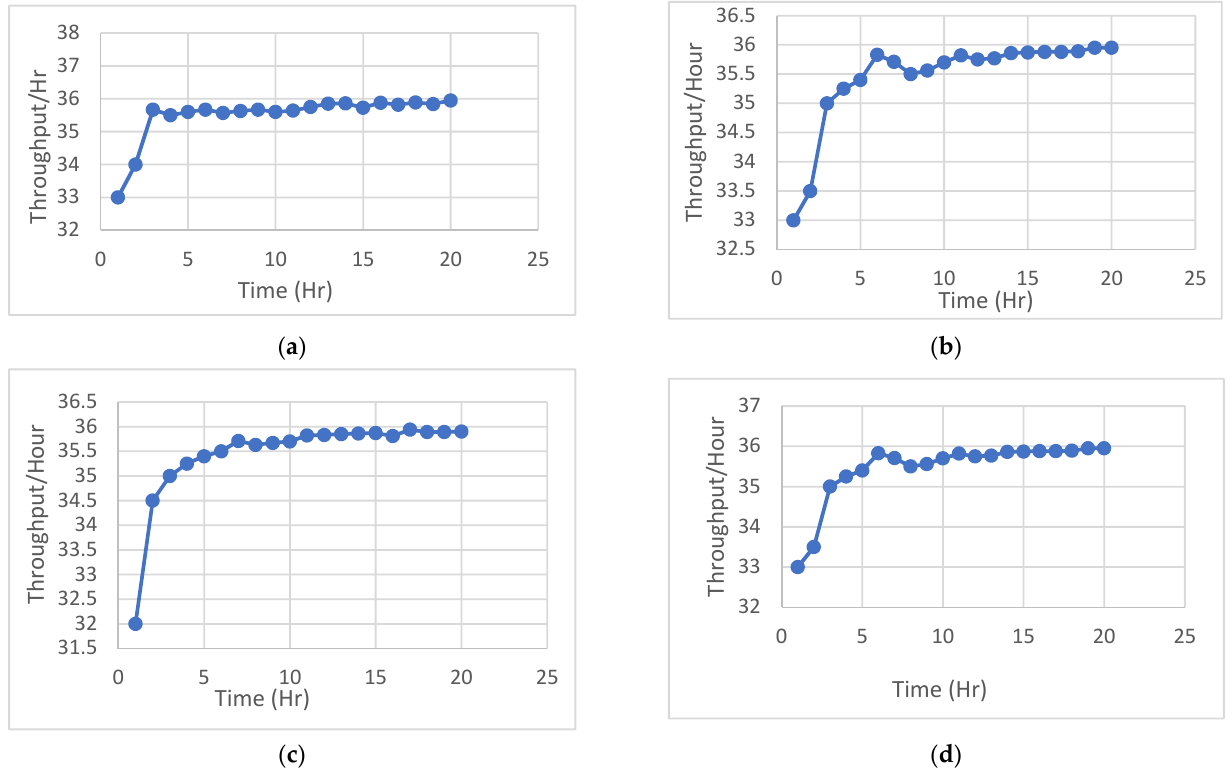
Figure 5. Plot of output to identify the warm-up period with the breakdown of machines. ( a ) One degree. ( b ) Two degrees. ( c ) Semi-flexible system. ( d ) Fully flexible